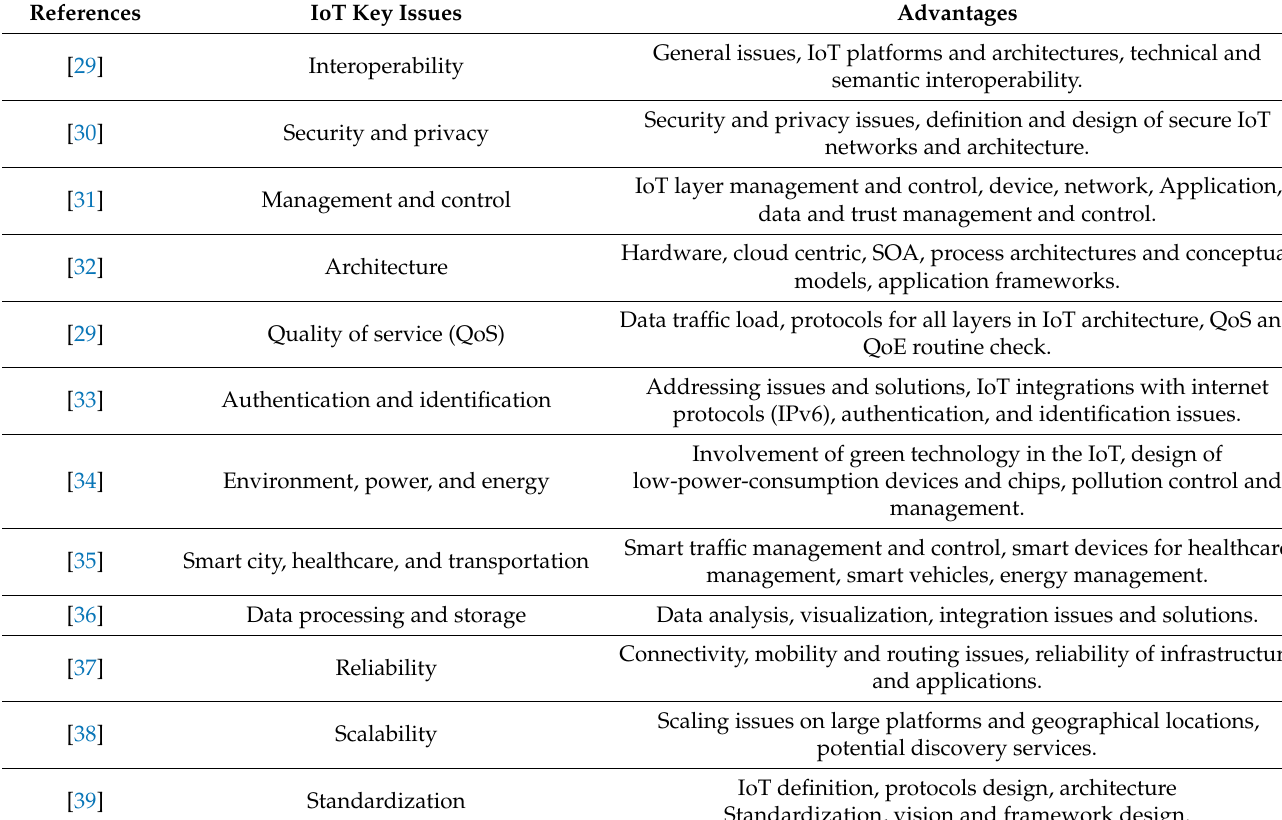
Table 2. IoT key issues.